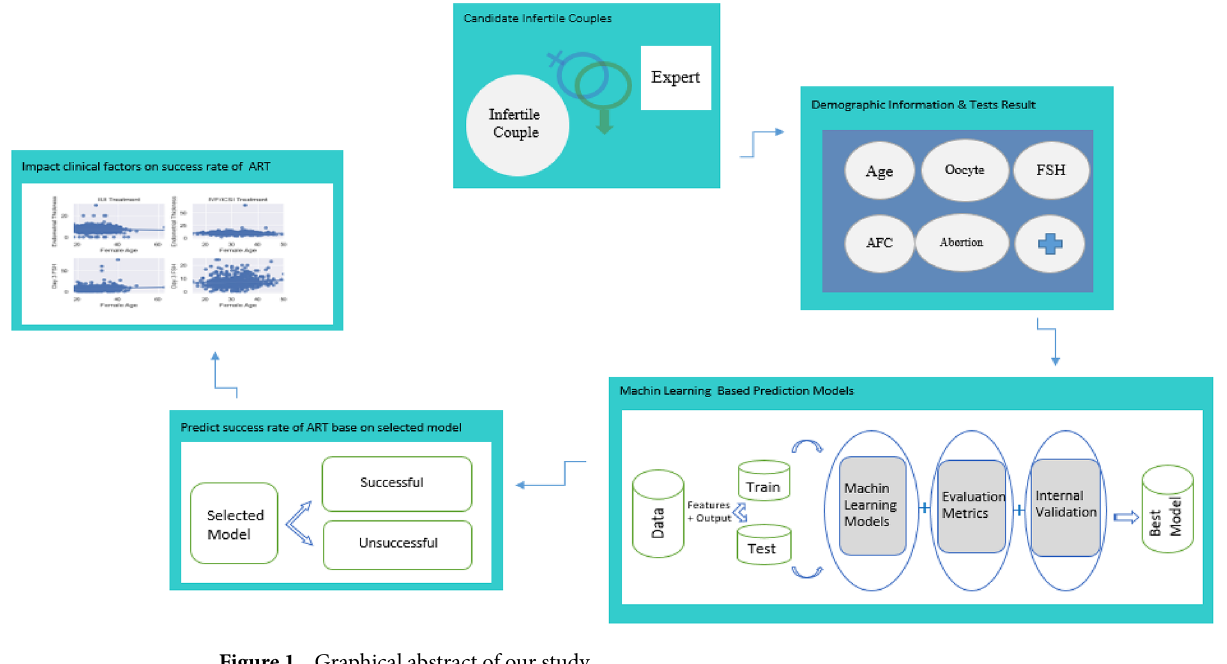
Figure 1. Graphical abstract of our